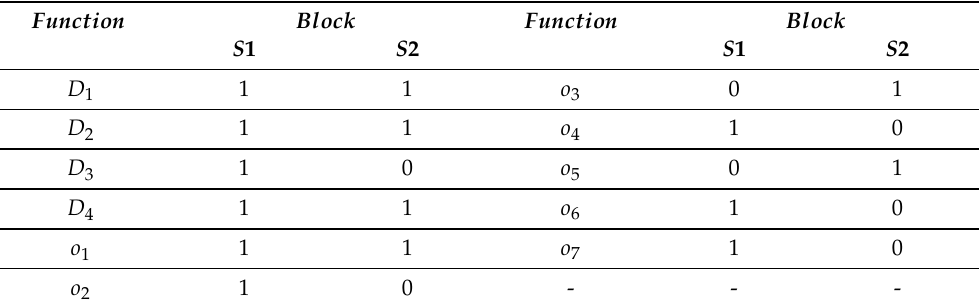
Table 5. Table of Block τ O